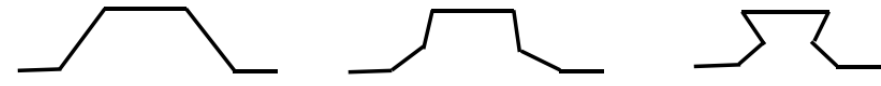
Figure 18. Lateral deformation — theoretical analysis.